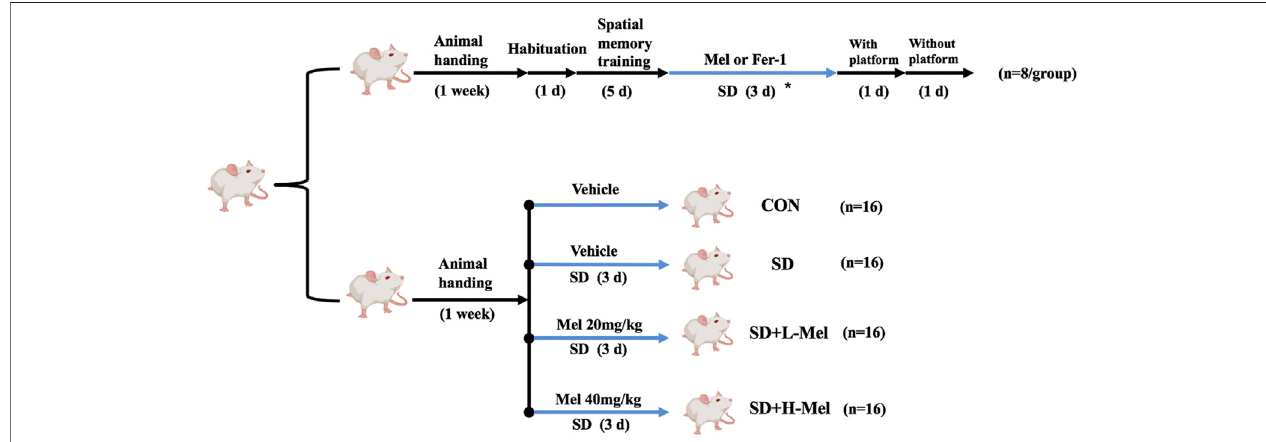
FIGURE 1 | Timeline of experimental design. The mice were divided into control group (CON), sleep deprivation group (SD), SD + low melatonin (20 mg/kg) supplement group (SD + L-Mel), SD + high melatonin (40 mg/kg) supplement group (SD + H-Mel), melatonin (20 mg/kg) supplement group (Mel) and SD + Fer-1 (1 mg/kg) supplement group (SD + Fer-1). The asterisk represents mice that were subjected to 72 h acute sleep deprivation and received treatment with or without Mel or Fer-1 supplementation.